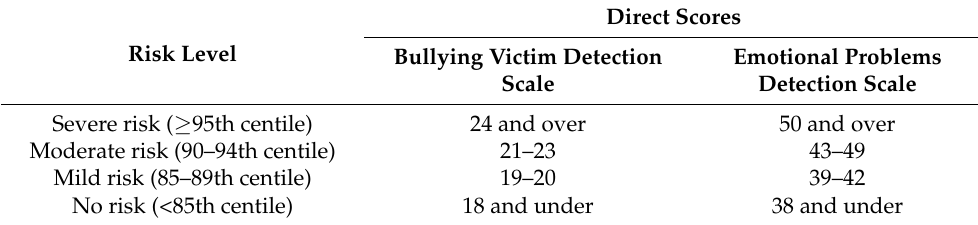
Table 10. Risk levels from raw